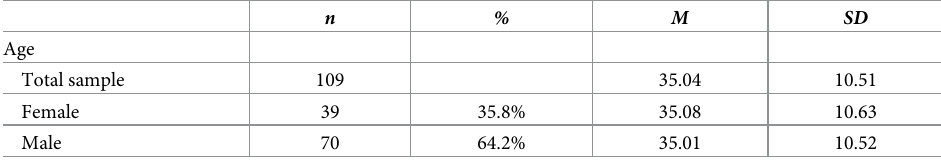
Table 1. Demographics of the participants in the interpersonal problem-solving